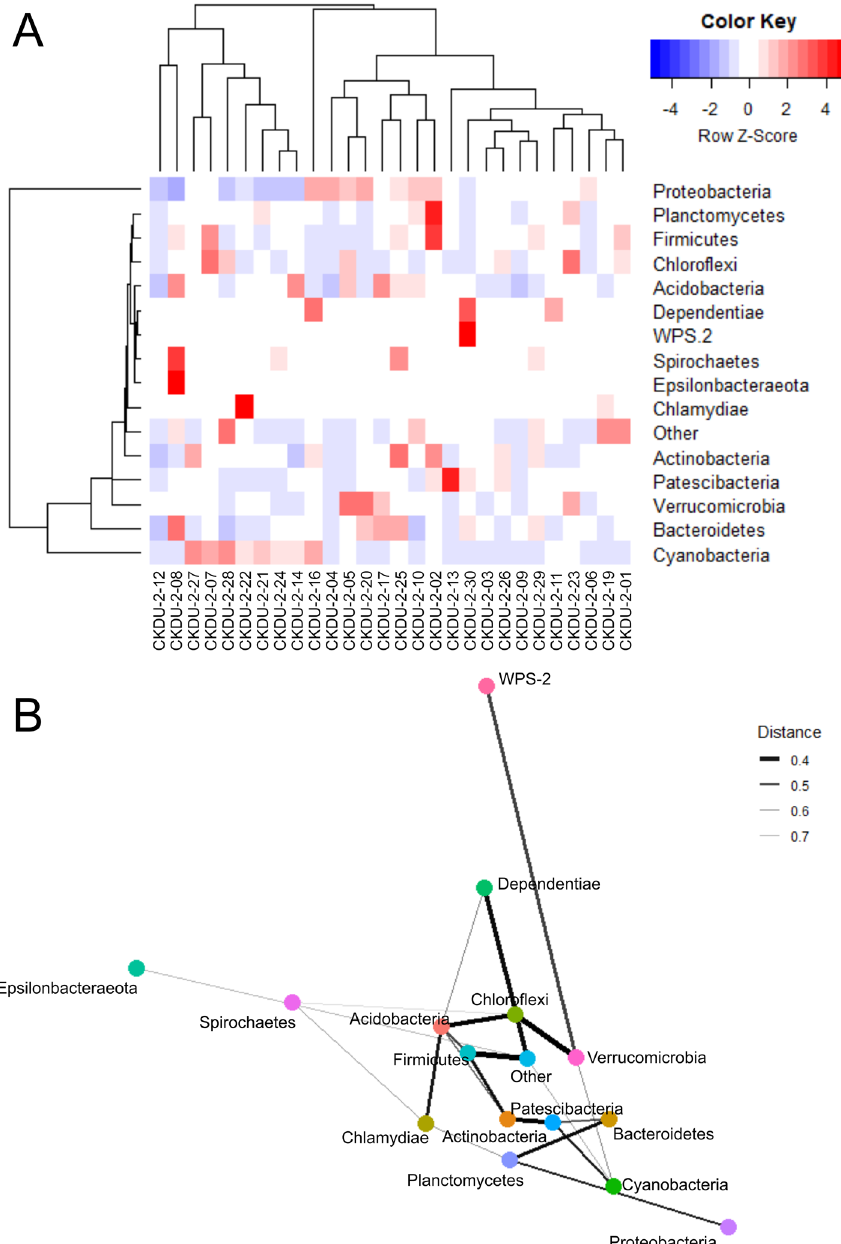
Figure 3. ( A ) Heatmap of microbial phyla (> 1% abundance), with cluster analyses for sample grouping (upper cluster diagram) and microbial groupings (left cluster diagram). Data are scaled by rows to have a mean of zero and a standard deviation of one. ( B ) Network map based on Bray–Curtis distance showing similarities between microbial genera counts for phyla with abundance > 1%. Thicker lines represent greater similarity between phyla counts, thinner lines represent less similarity between phyla counts. Data normalized to the median sequencing